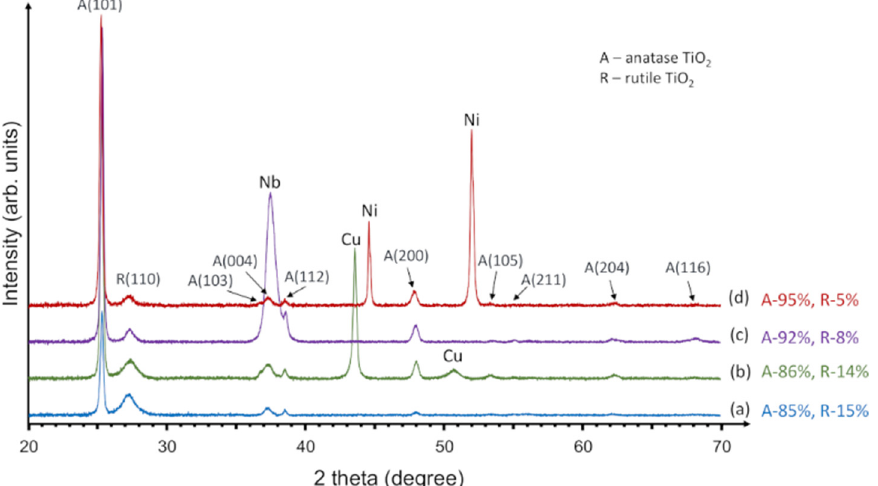
Figure 1. XRD patterns of ( a ) the as deposited carbon-doped TiO 2 film and carbon-doped TiO 2 films deposited on ( b ) the Cu underlayer, ( c ) Nb underlayer and ( d ) Ni underlayer. deposited on ( b ) the Cu underlayer, ( c ) Nb underlayer and ( d ) Ni